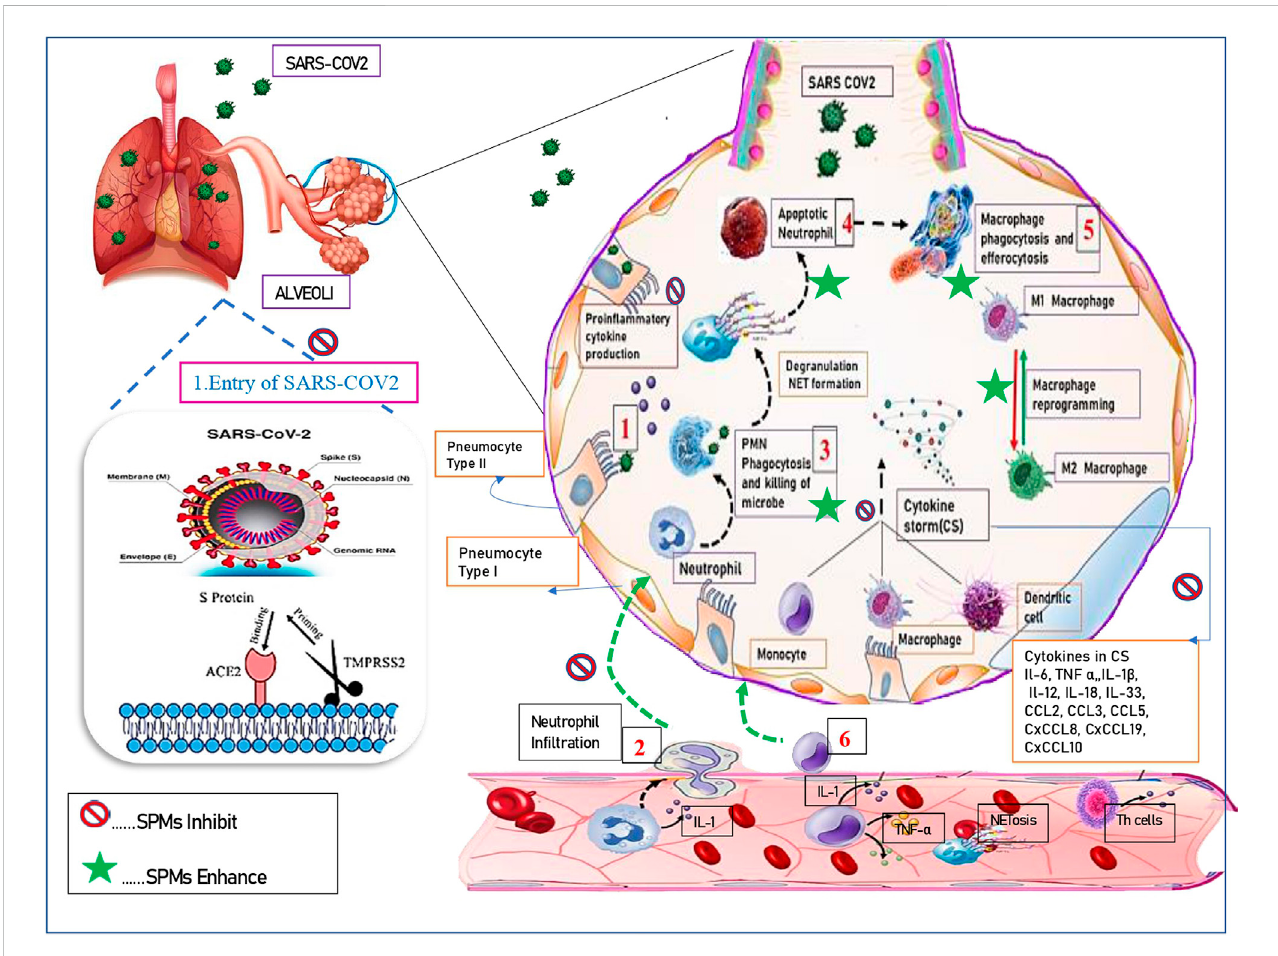
FIGURE 1 Resolutionofin fl ammationusingSPMs.1)Residentcellsdetectthestimulusandinitiatethein fl ammatorycascade.2).Thereisin fi ltrationofgranulocytes [such as neutrophils, monocytes. 3) PMN Phagocytosis and killing of microbes. 4) Apoptosis of neutrophils after, degranulation and NET formation. 5) Macrophagephagocytosisandefferocytosis. 6)Monocytes/macrophages,fromthebloodintotheaffectedtissue.Resolutionofin fl ammationisenhancedby SPMs wherein they kill microorganisms, stop entry of virus. Inhibit secretion of proin fl ammatory cytokines, enhance release of pro-resolving mediators. The reprogramming of macrophages from classically (M1) to alternatively (M2) activated cells further ampli fi es the resolution